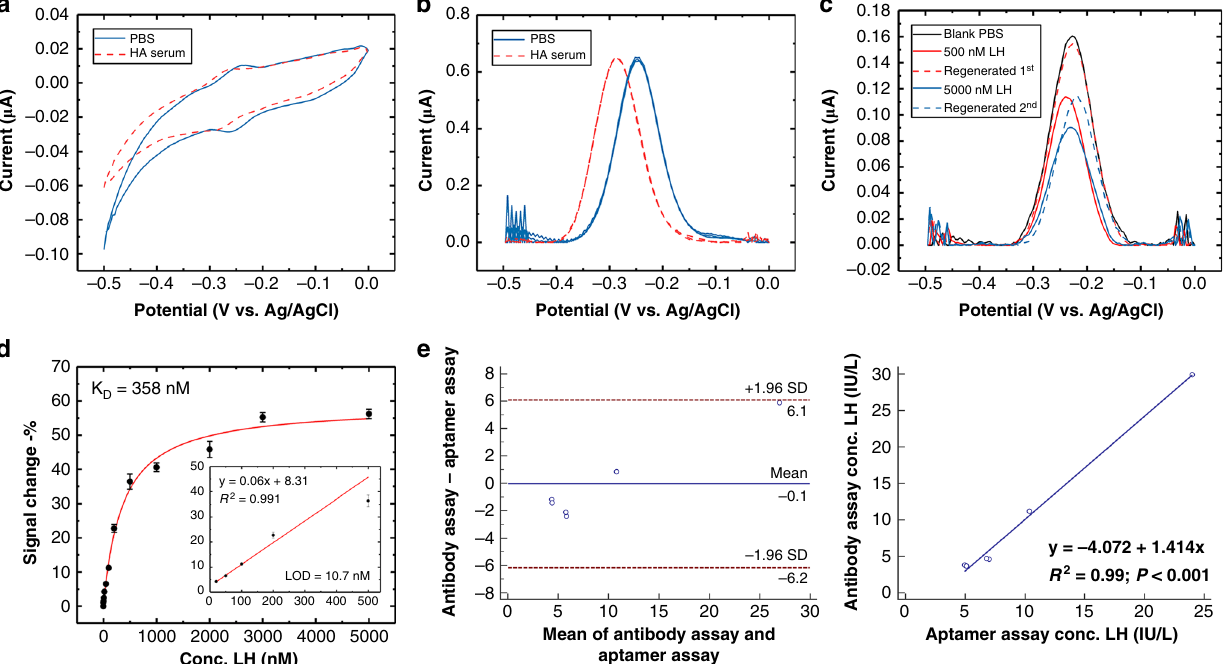
Fig. 4 Performance of RAPTER in undiluted clinical serum samples. a CV scan of the LH aptamer sensor in PBS and then in undiluted hypothalamic amenorrhoea serum. b SWV of the LH aptamer sensor in PBS and then in undiluted hypothalamic amenorrhoea serum. c Regeneration under an undiluted serum condition. The dashed line represents the regenerated peak obtained after using the automatic platform washing step. d Concentration – response curve using SWV methods. The % of the signal change indicates that the change is a signal off model. The K D is estimated to be 358 nM, and the dynamic range is from 5 to 500 nM. Means ± s.d. from three independent experiments are shown ( n = 3). e Pilot study on measuring LH concentration. Six samples with a known wide variation in the range of LH concentration measured by the aptamer and clinical gold standard immunochemical assay. Bland – Altman plot and linear regression plot of the LH concentration obtained by the two methods, R 2 = 0.93. Source data are provided as a Source Data fi